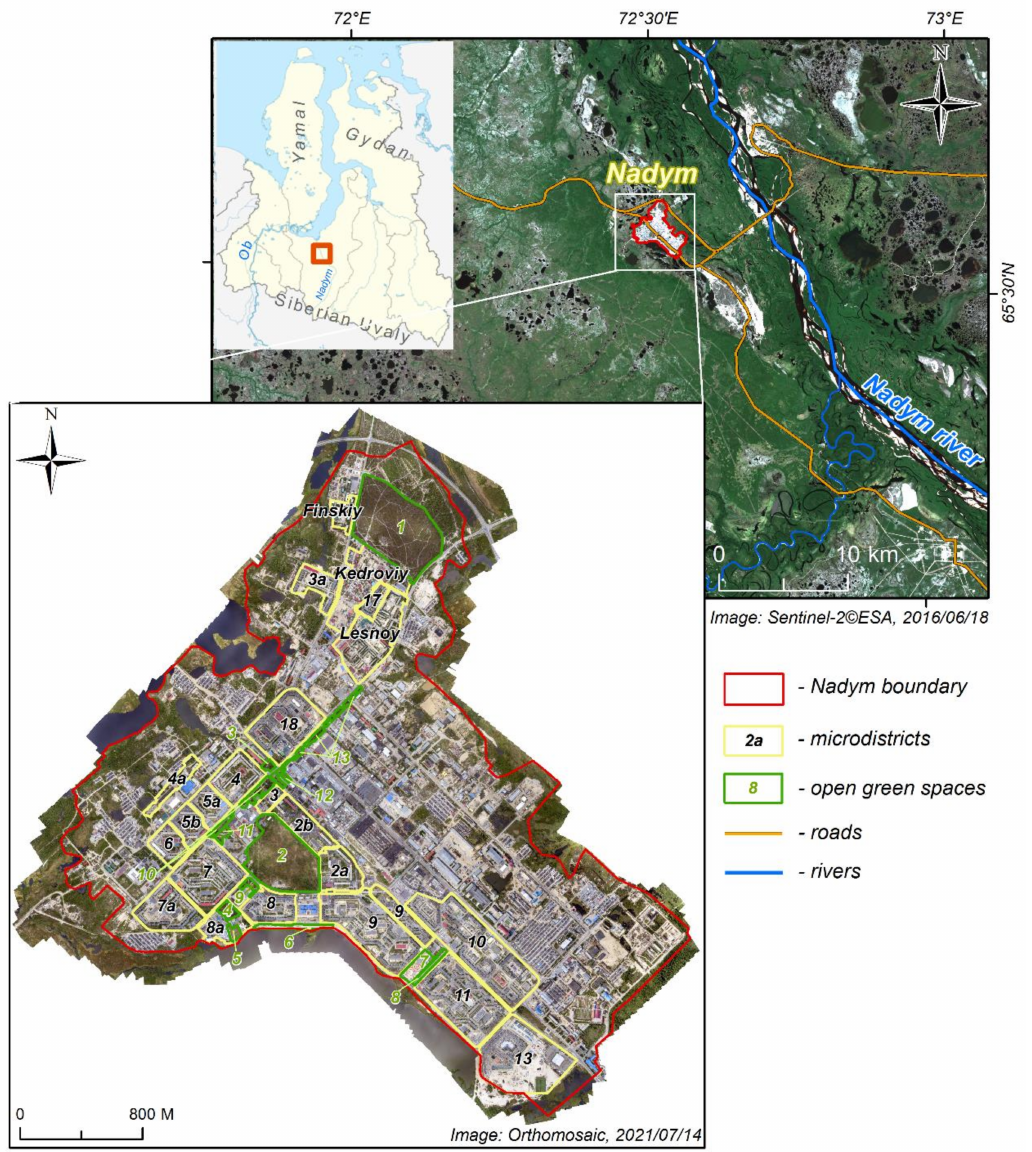
Figure 1. Study area. Open green spaces: 1. Cedar Grove; 2. Kozlov’s park; 3. Square of Eternal Flame; 4. Square named after V.V. Remizov; 5. Square near Yubileiny hotel complex; 6. Boulevard on the embankment named after S.A. Orudzhev; 7. Strizhov Square; 8. Strizhov Boulevard; 9.